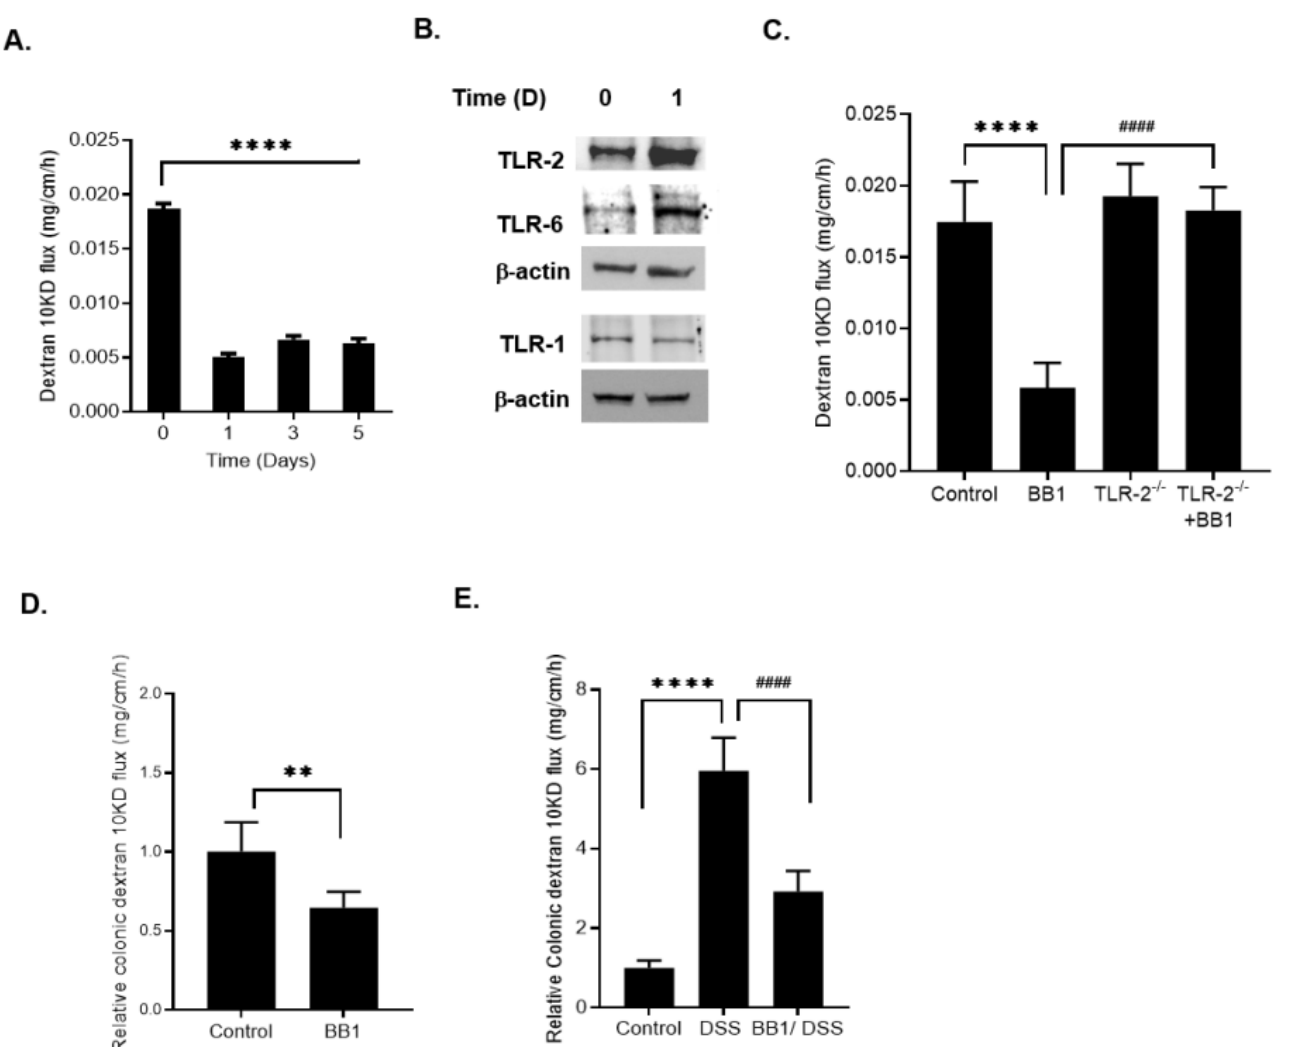
Figure 5. Effect of BB1 on mouse intestinal permeability in-vivo and DSS-induced increase in mouse colonic permeability and inflammation. ( A ) BB1 (1 × 10 9 CFU/mL) caused a time-dependent decrease in mouse intestinal permeability to dextran-10 kDa; **** p < 0.0001 vs. control. ( B ) BB1 oral gavage caused an increase in TLR-2 and TLR-6 but not TLR-1 protein expression in mouse small intestinal tissue. ( C ) BB1 induced enhancement of mouse intestinal permeability was inhibited in TLR-2 −/− mice. **** p < 0.0001 vs. control; #### p < 0.0001 vs. BB1. ( D ) BB1 administration caused a decrease in mouse colonic permeability to dextran-10 kDa; ** p < 0.01 vs. control. ( E ) DSS (3% w/v ) caused a marked increase in mouse colonic permeability to dextran-10 kDa, and BB1 prevented the DSS-induced increase in mouse colonic permeability over the 7-day experimental period. (BB1 treatment started 2 days prior to the 7-day DSS treatment). **** p < 0.0001 vs. control; #### p < 0.0001 vs. DSS treatment.